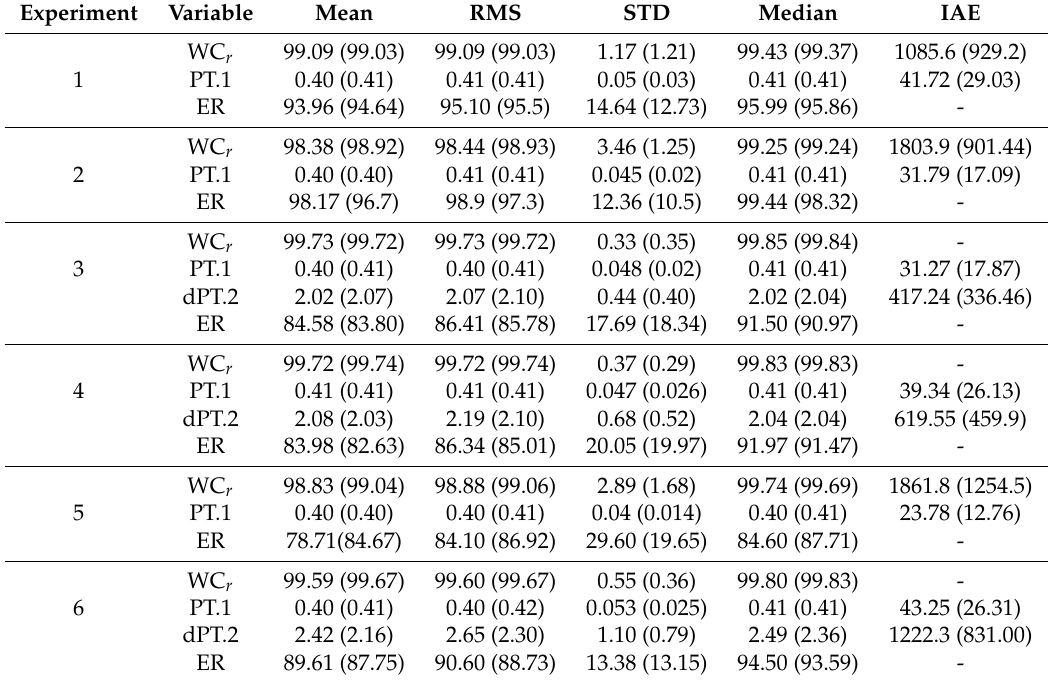
Table 8. Numerical comparison of Experiments 1–6. Values in parentheses are calculated after the initial transient is over, i.e., from t = 200